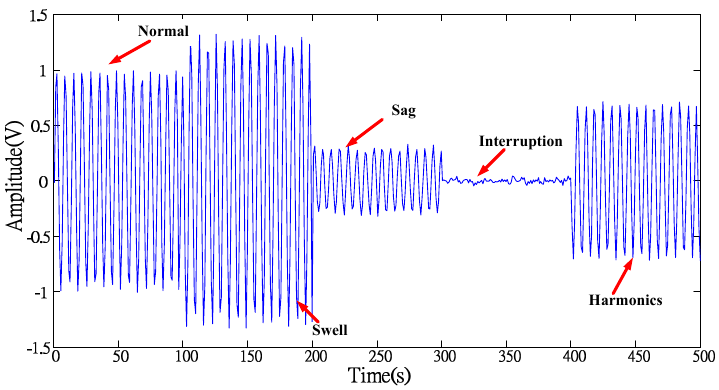
Figure 8. Power system signal with 5% noise